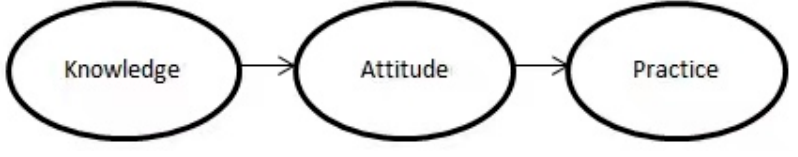
Figure 2. The KAP model. Source: Wang et al. [25]